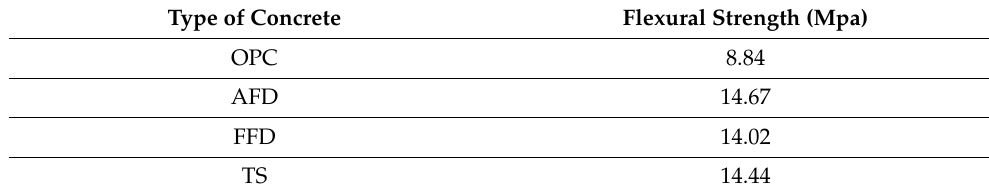
Table 5. Flexural